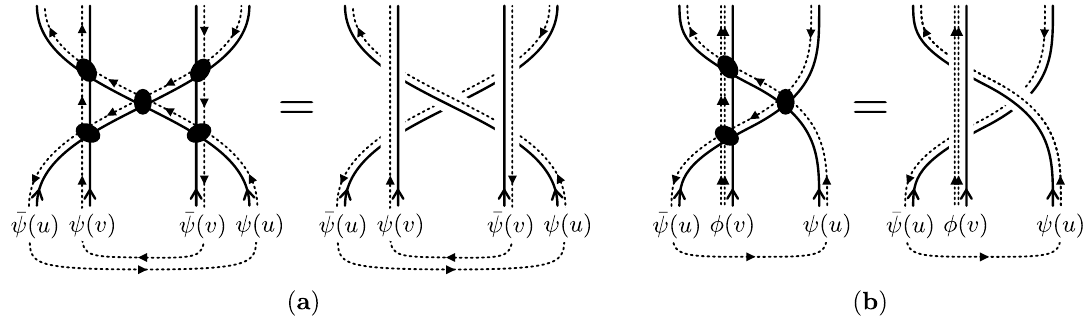
Figure 5 . The square limit axiom (2.5) for fermions is consistent with factorization because the product of S-matrices in the second term becomes trivial when evaluated on a factorized ansatz. To see this, we note that two conjugate fermions of equal rapidity scatter trivially with a scalar ( b ) and with another pair of conjugate fermions ( a ). Here, the dashed directed lines represent the contraction of the SU(4) index, the solid arrow represents the flow of U(1) R the black dots represents the R-matrices in (F.2) and